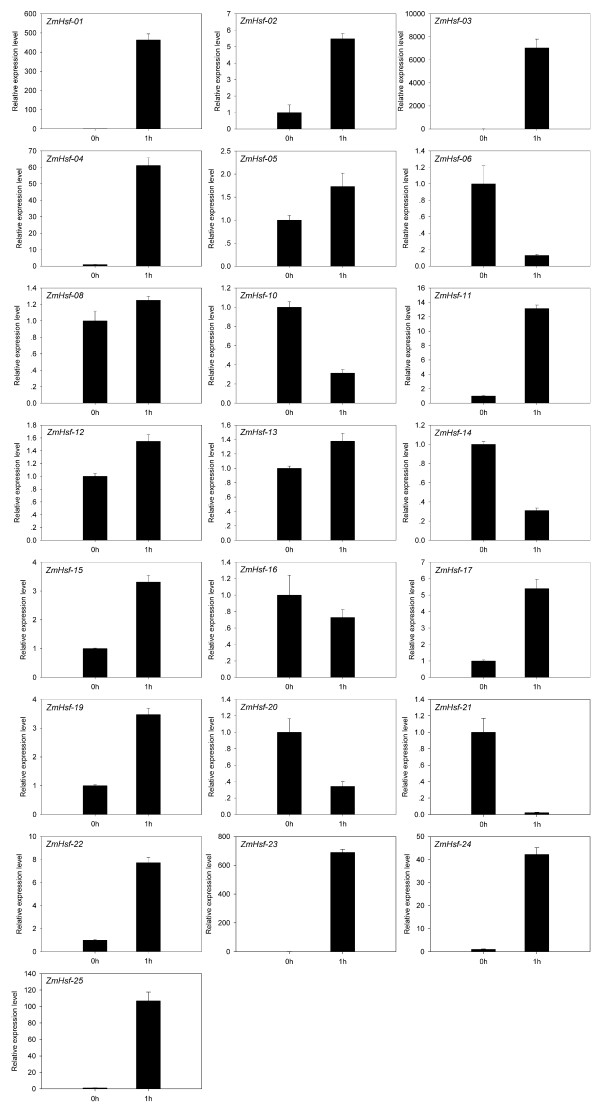
Relative gene expression of ZmHsfs analyzed by qRT-PCR responsed to heat stress treatment. qRT-PCR data was normalized using maize Actin 1 gene and are shown relative to 0 h. X-axes are time course (0 h and 1 h) and y-axes are scales of relative expression level (error bars indicate SD).